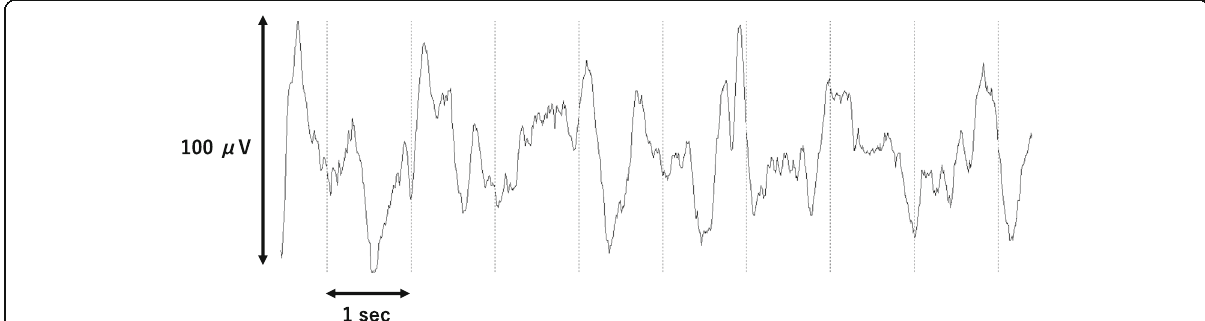
Fig. 1 Electroencephalogram before anesthetic induction. This EEG shows lower frequency dominance that is not observed in the healthy